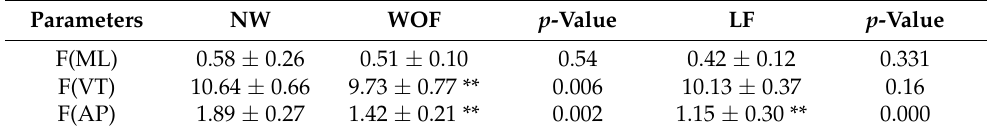
Table 2. Means and standard deviations (mean ± SD) of the maximum ground reaction force (GRF) during two progressive motions and NW. Units: N/BW.